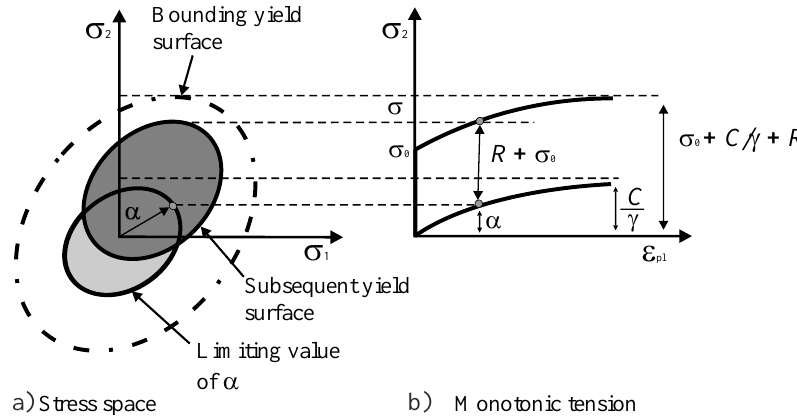
Figure 4. Graphical depiction of the combined hardening growth in the ( a ) stress space shown by the yield surface and ( b ) under monotonic tension presented as a stress – strain diagram, redrawn from [27] under the CC-BY license.